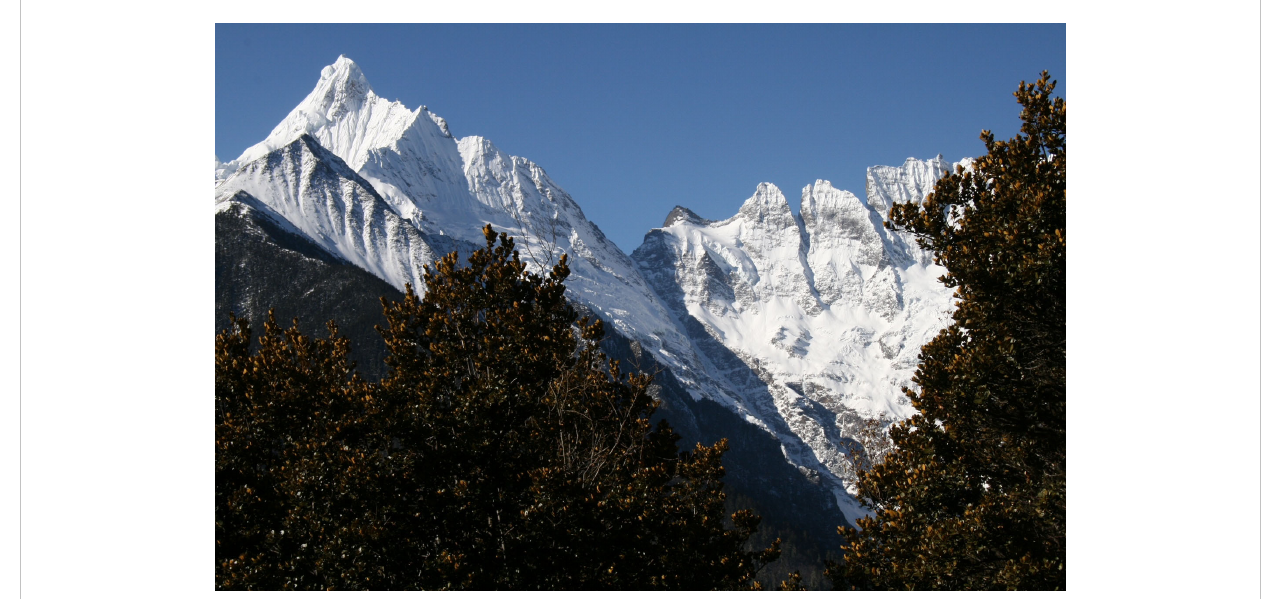
FIGURE 1 Quercus pannosa growing in Shangri-la, Yunnan Province, China (Provided by Dr. Jianzhong Ma). Environmental factors and tree size can signi fi cantly affect the leaf functional traits (see Ma et al. in this special